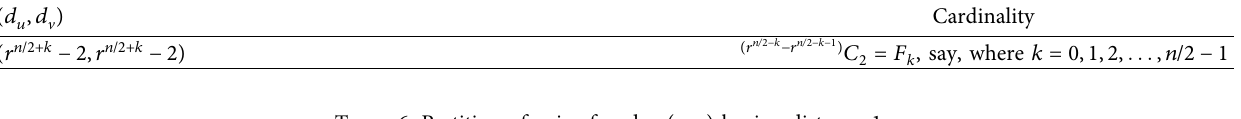
Table 5: Partition of pair of nodes ( u,v ) having distance 1.